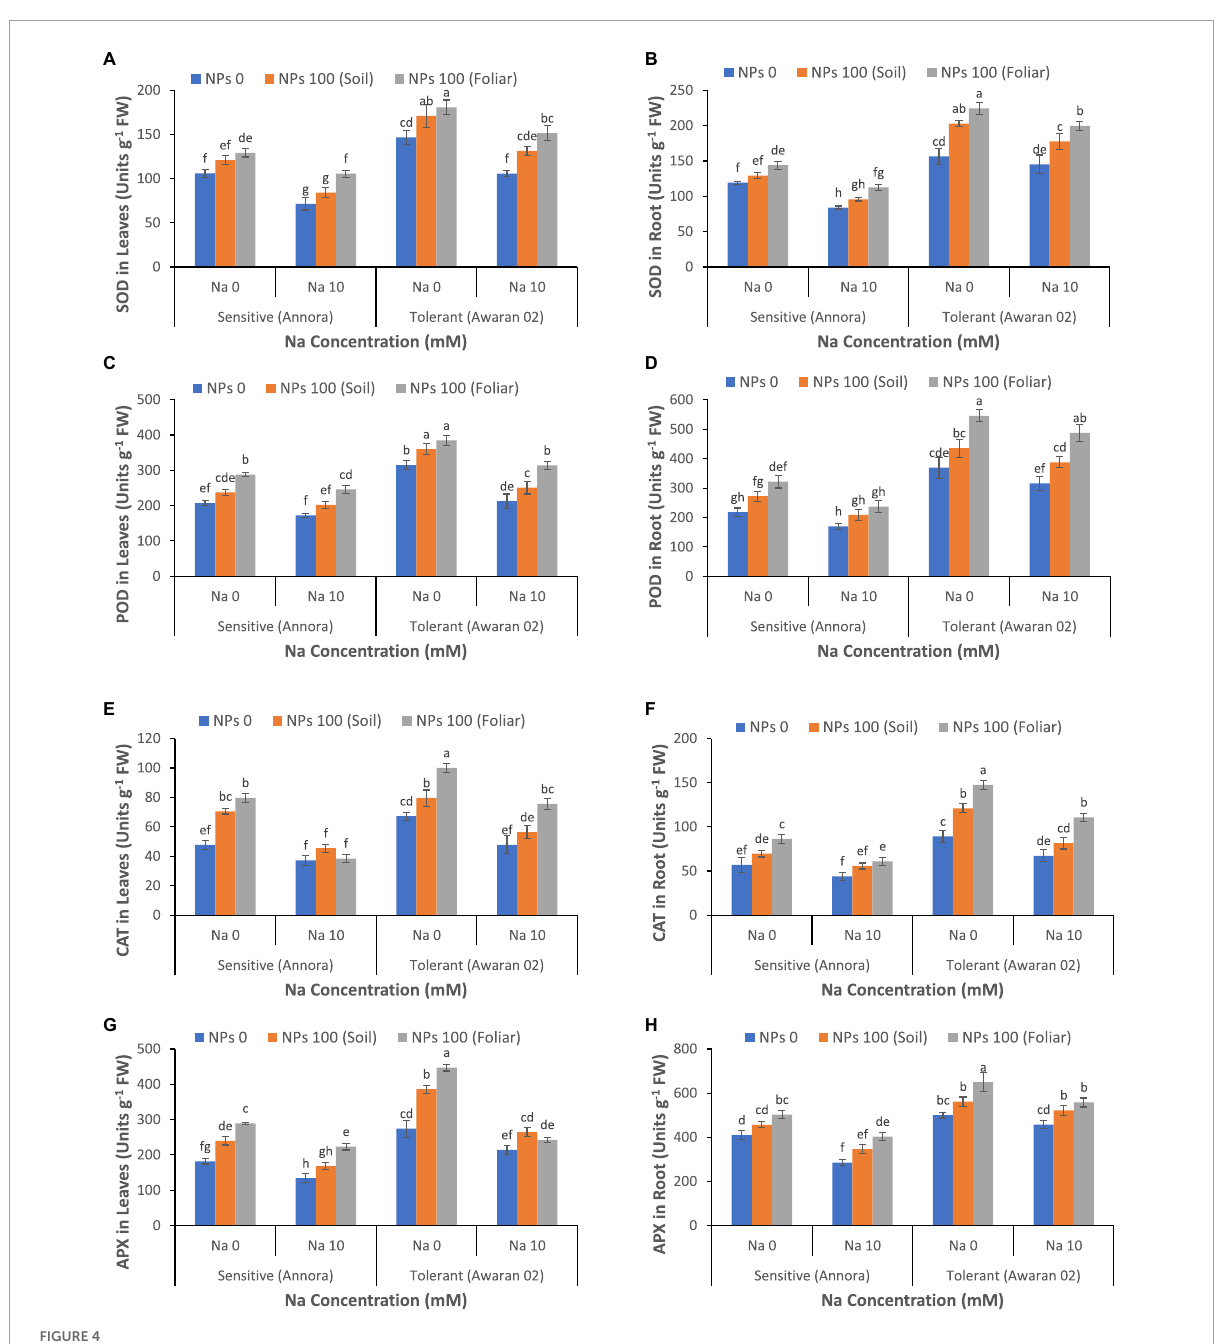
FIGURE4 Effects of different concentrations of NaCl (0 and 100 mM) and ZnO NPs (0, 100 mg kg − 1 soil, and 100 mg L − 1 foliar) on (A) SOD in leaves, (B) SOD in roots, (C) POD in leaves, (D) POD in roots, (E) CAT in leaves, (F) CAT in roots, (G) APX in leaves, (H) APX in roots of two barley genotypes Annora (salt sensitive), and Awaran 02 (salt tolerant). Values are expressed as means of three replicates with standard deviations. Different letters indicate that values are significantly different at a p -value <